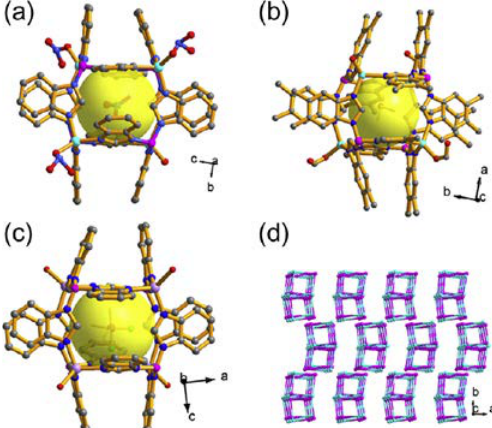
Figure 3. ( a ) The cubic cage in the BIF-26 framework. ( b ) The cubic cage in the BIF-27 framework. ( c ) The cubic cage in the BIF-58 framework. ( d ) The packing of cages in the BIF-27 framework. Color codes: Zn, pale blue; Co, lavender; B, purple; O, red; C, gray; N, blue. Partial H atoms are omitted for clarity. Reprinted with permission from [44].